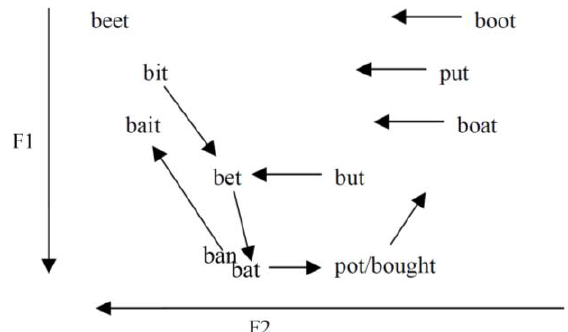
Source: Adapted from Eckert